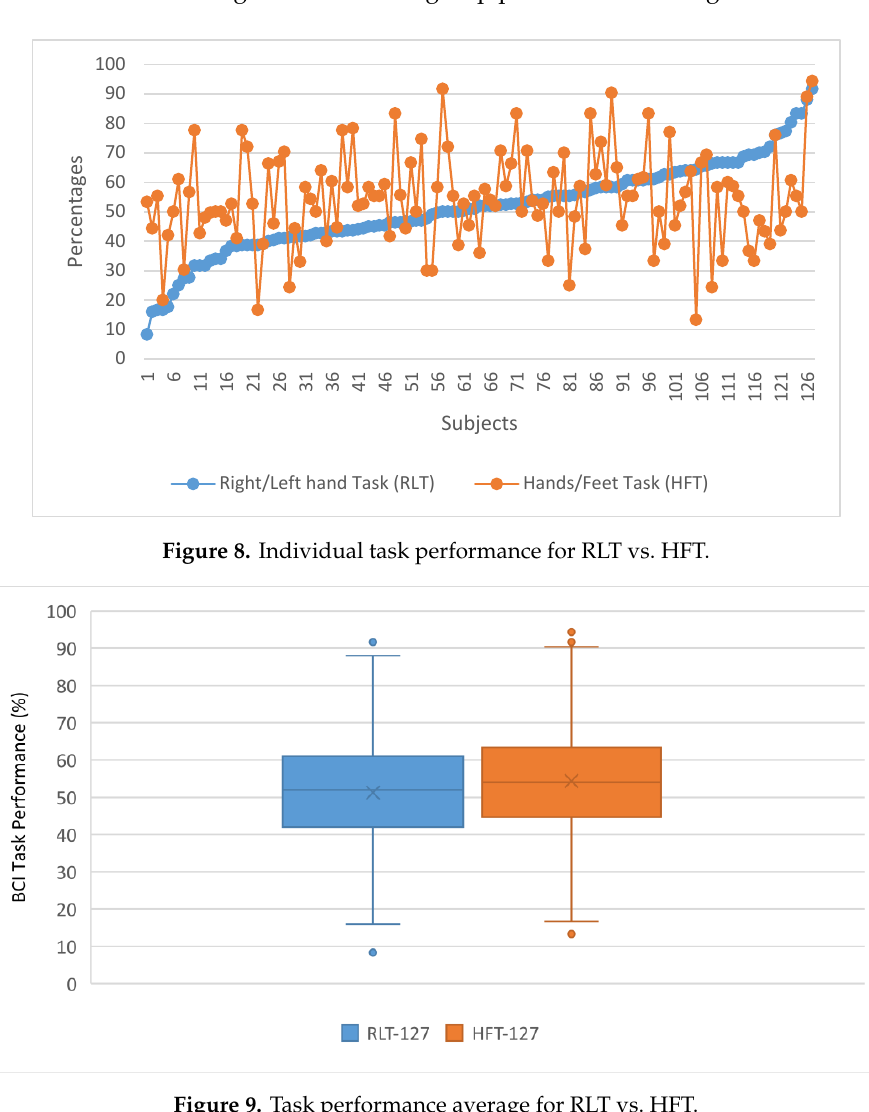
Figure 9. Task performance average for RLT vs. HFT.